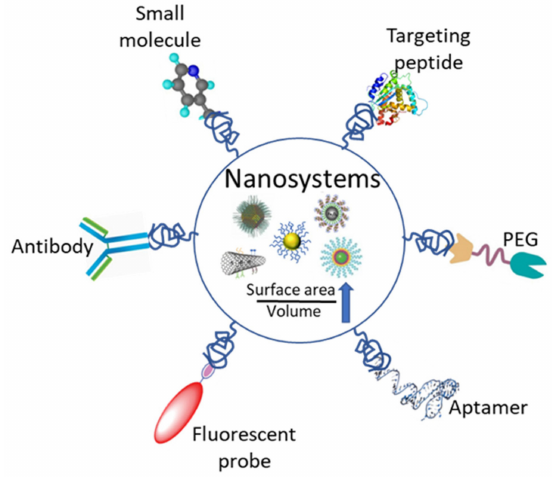
Figure 1. A representation of the various functionalization moieties for nanosystems utilized for the detection of biomolecules in diagnostics. Table 1. Nanomaterials and their common applications in